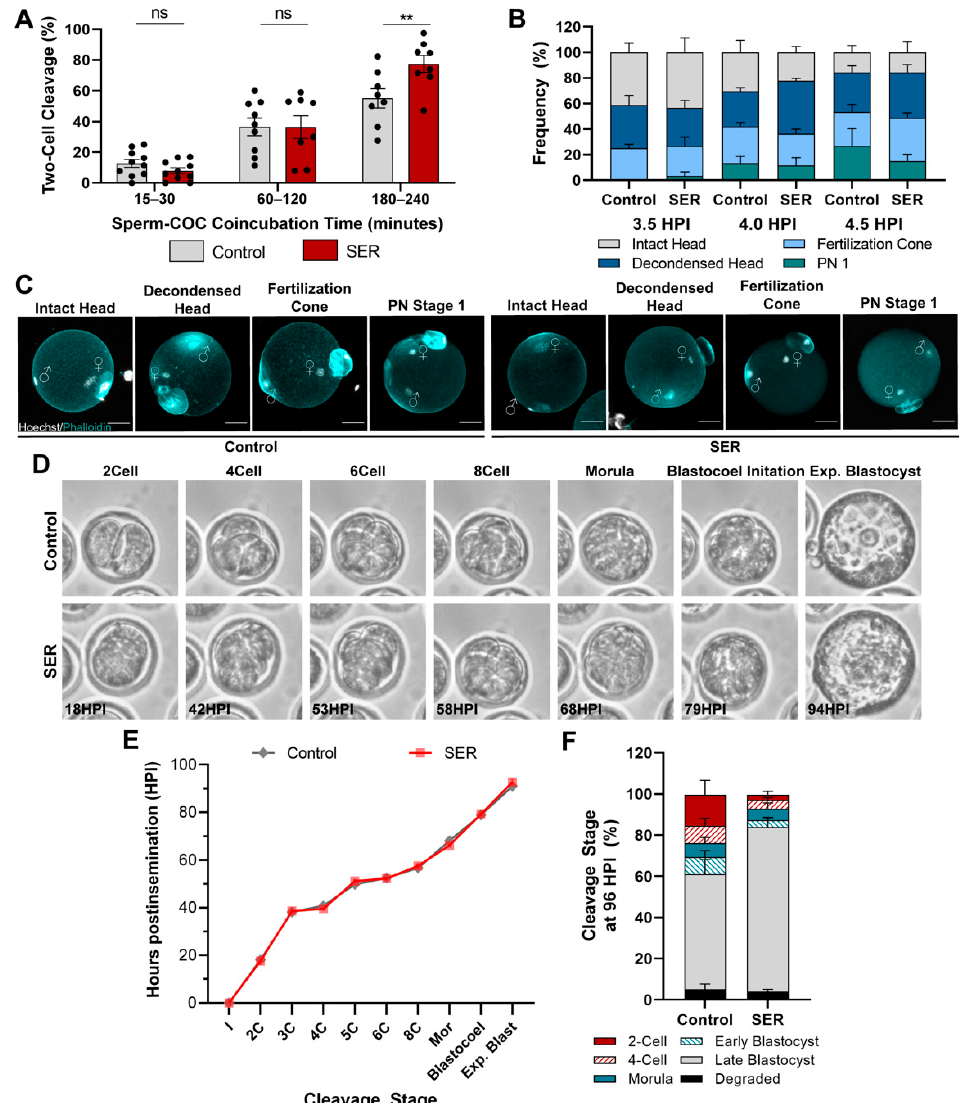
Figure 1. Effects of the SER treatment on early fertilization events. ( A ) Sperm–oocyte penetration time curve assay. Control- and SER-treated sperm were co-incubated with cumulus–oocyte complexes (COCs) for 15–30, 60–120, or 180–240 min before removal and evaluation of fertilization 24 h post-insemination (HPI). N = 6 independent experiments, 20–30 oocytes per time point per condition. Data are mean ± s.e.m. ns p > 0.05, ** p < 0.001 (Mixed Model Analysis, Tukey’s). ( B ) Sperm head decondensation comparison at 3.5, 4.0, and 4.5 HPI by 3D-confocal analysis. Analysis categories: intact sperm head, sperm head decondensed, formation of the fertilization cone, and initial formation of pronucleus stage 1 (PN 1). N = 4 independent experiments, 20–30 fertilized embryos per time point per condition. Data are mean ± s.e.m. ns p > 0.05 (Two-way ANOVA). ( C ) Representative confocal microscopy images of control- and SER-fertilized oocytes in each sperm head decondensation category. Cortical actin cytoskeleton (Phalloidin) and DNA (Hoechst) are shown in cyan and grey, respectively. Scale bar: 20 µ m. ( D ) Representative time-lapse microscopy images of control- and SER-generated embryos. ( E ) Quantification of time-lapse microscopy analysis of control- and SER-generated embryos. I = insemination, Mor = Morula. N = 4 independent experiments, 10– 15 embryos per experiment per condition. Data are mean ± s.e.m. ns p > 0.05 (unpaired T ‐ test with Welch’s correction). ( F ) Quantification of control ‐ and SER ‐ generated embryos at 96 HPI. N = 11, control: 247, SER: 352.